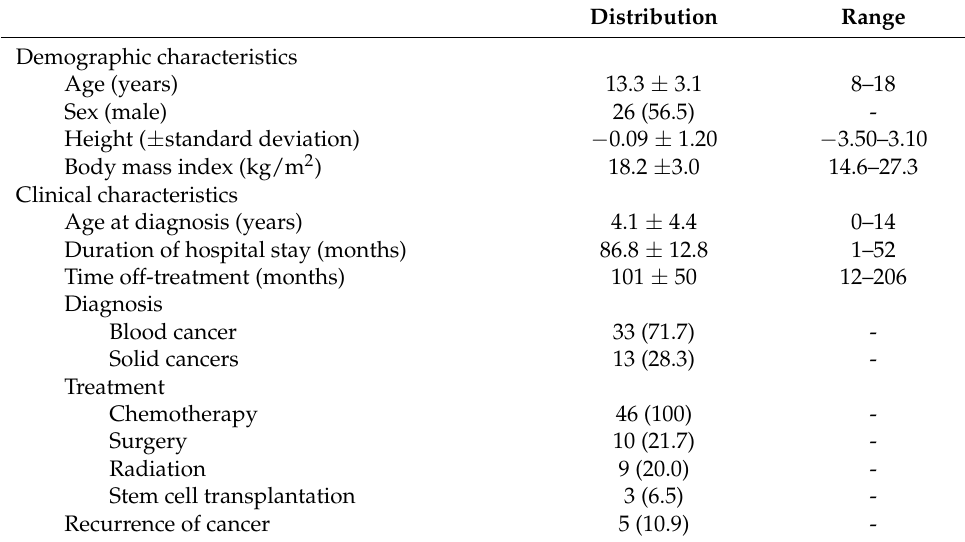
Distribution Range